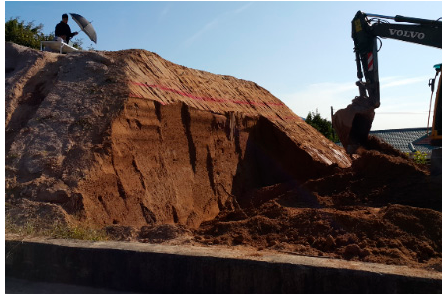
Figure 5. Installation of a sensor: ( a ) Penetration of the sensor into the model slope; ( b ) Connection of the sensor through a wire.